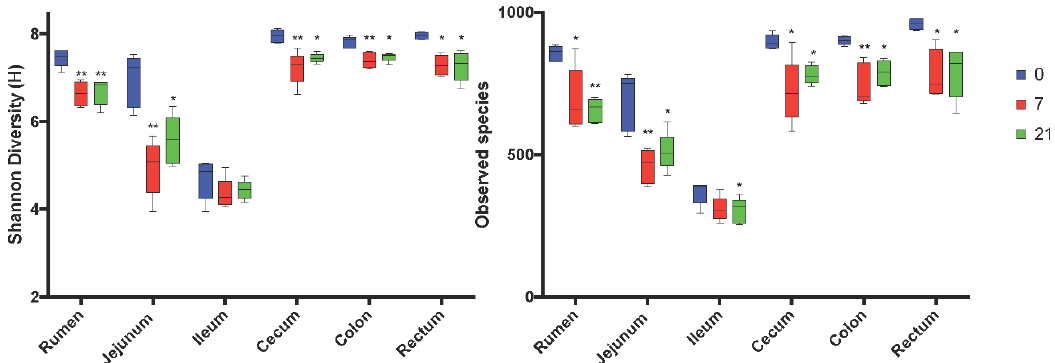
Figure 1. Comparison of Shannon and Observed Number of species alpha-diversity indices by region of the digestive tract and treatment. 0 = no grain feeding, 7 = moderate grain feeding for 7 d, 21 = moderate grain feeding for 21 d. * = significantly ( p < 0.05) different from D0 by region, ** significantly ( p < 0.01) different from D0 by region.